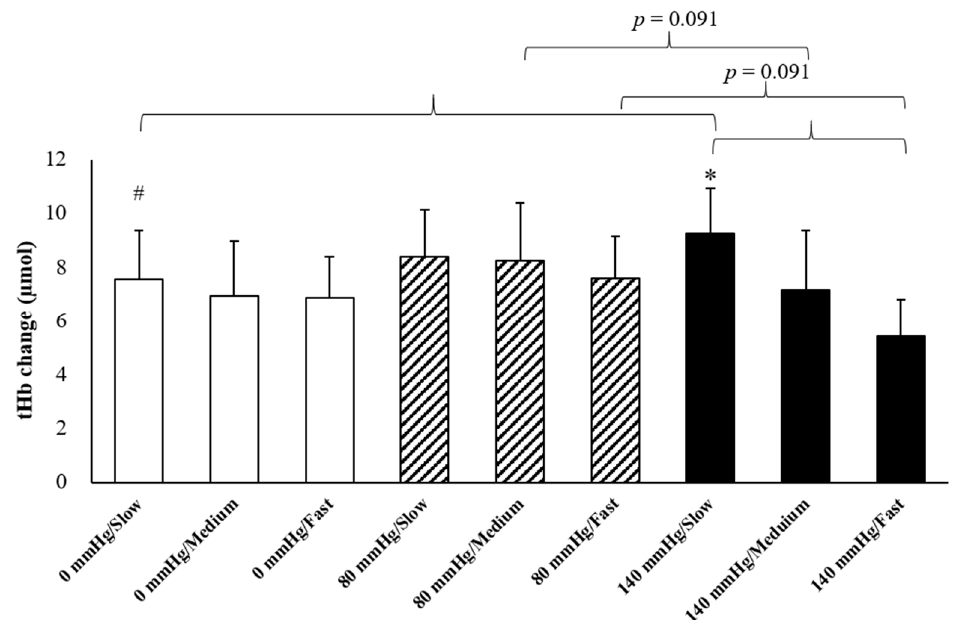
Figure 4. Changes in tHb under various pressure and rowing cadence conditions during the recovery period (mean ± SE). * Significantly different from a high cadence under 140 mmHg. # Significantly different from 140 mmHg under the same cadence.